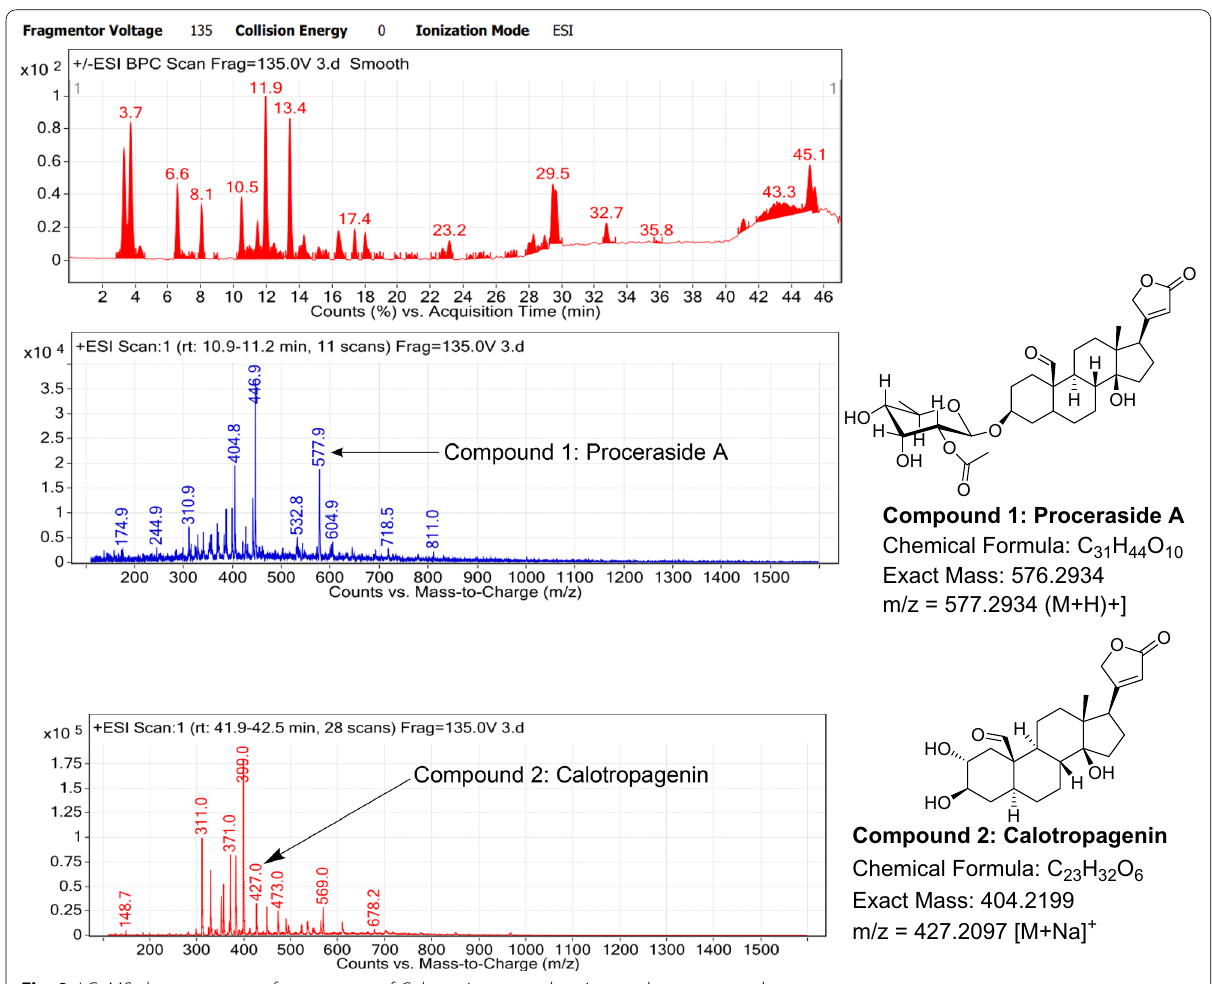
Fig. 9 LC–MS chromatogram of root extract of Calotropis procera showing marker